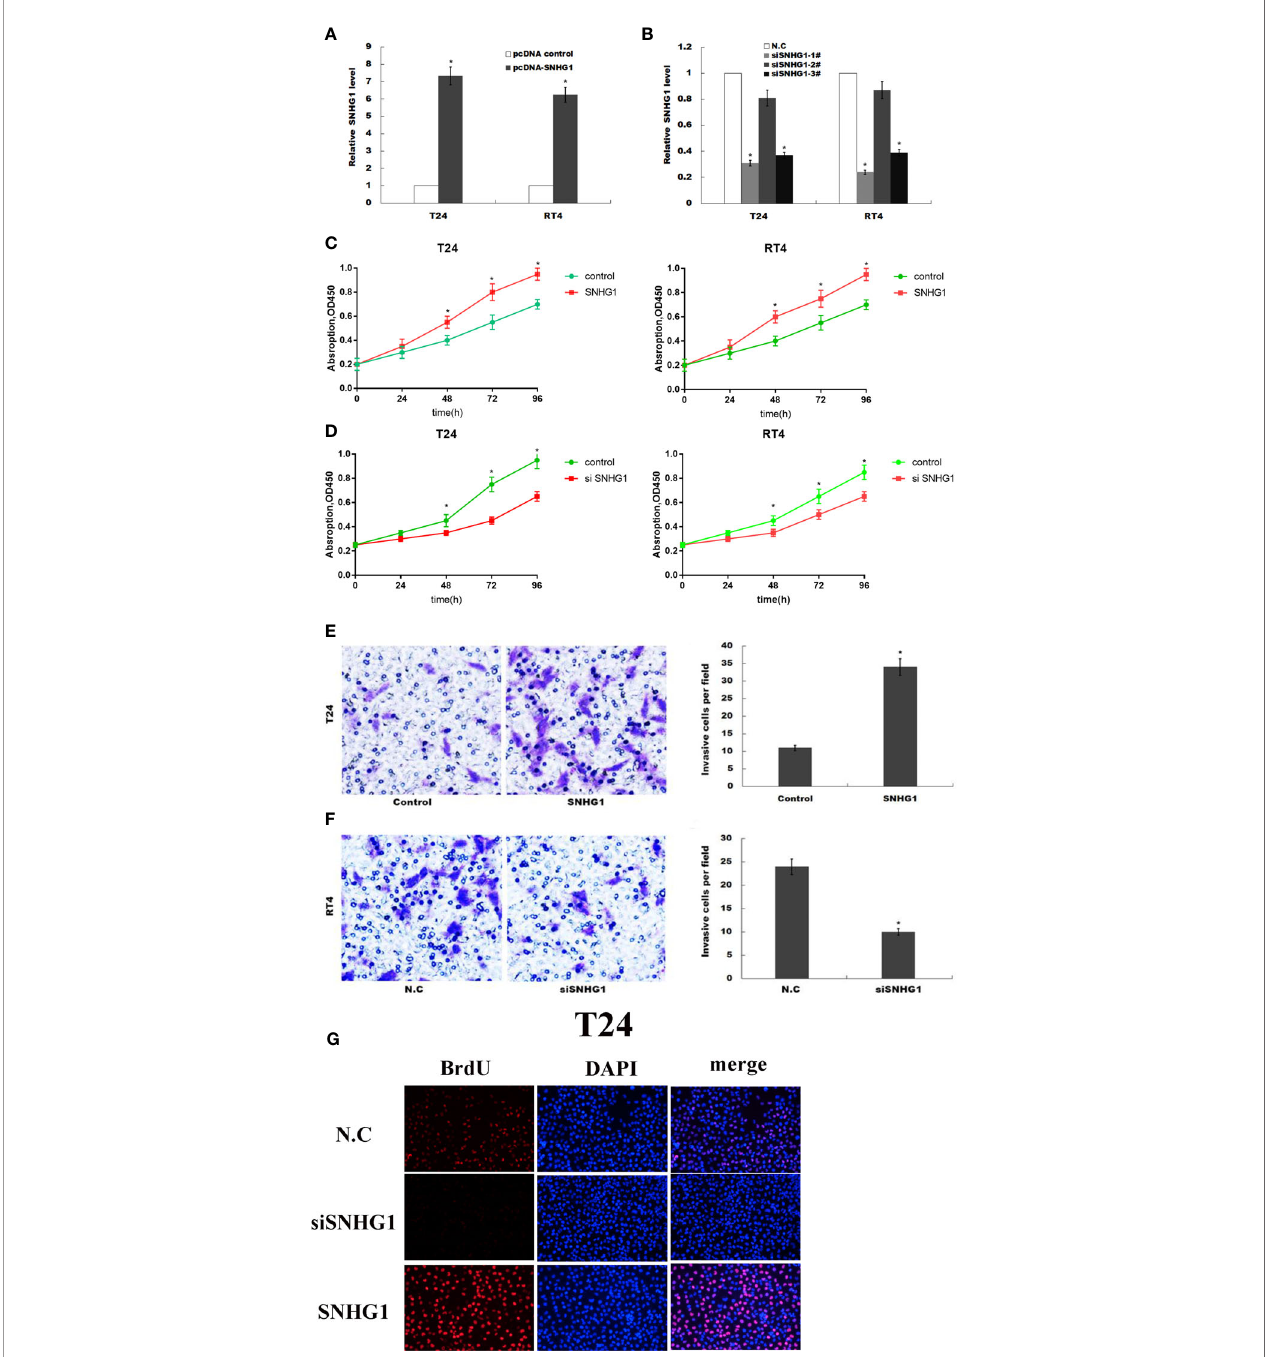
FIGURE 2 | SNHG1 promotes bladder cancer cell proliferation and invasion. (A) Expression levels of SNHG1 in T24 and RT4 bladder cancer cells. (B) Ef fi ciency of the three sh- SNHG1 sequences in T24 and RT4 bladder cancer cells. (C) T24 and RT4 bladder cancer cells were cultured with overexpressed SNHG1 or control, MTT assay was used to evaluate the number of viable cells in T24 and RT4 bladder cancer cells. (D) T24 and RT4 bladder cancer cells were cultured with sh- SNHG1 or control, MTT assay was used to evaluate the number of viable cells in T24 and RT4 bladder cancer cells. (E) T24 bladder cancer cells were cultured with overexpressed SNHG1 or control, cell invasion assay was used to explore cell invasion of T24 bladder cancer cells. (F) RT4 bladder cancer cells were cultured with sh- SNHG1 or control, cell invasion assay was used to explore cell invasion of RT4 bladder cancer cells. (G) T24 bladder cancer cells were cultured with sh- SNHG1 , overexpressed SNHG1 or control, bromodeoxyuridine (BrdU) incorporation assay was used to explore cell proliferation of T24 bladder cancer cell (Data presented as mean ± SD, *p < 0.05 compared to the